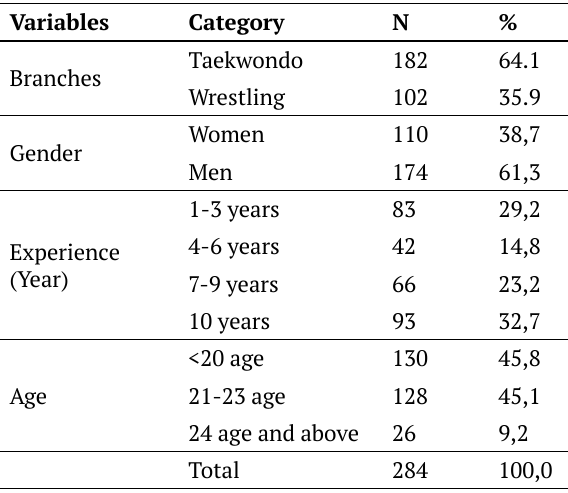
Table 1. Participant Characteristics of